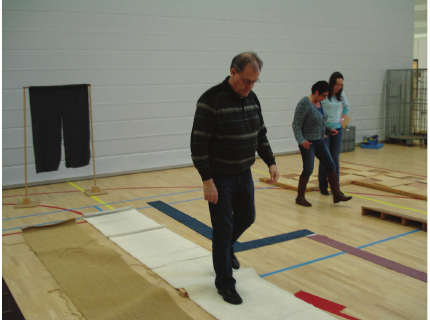
Figure 1: Obstacle